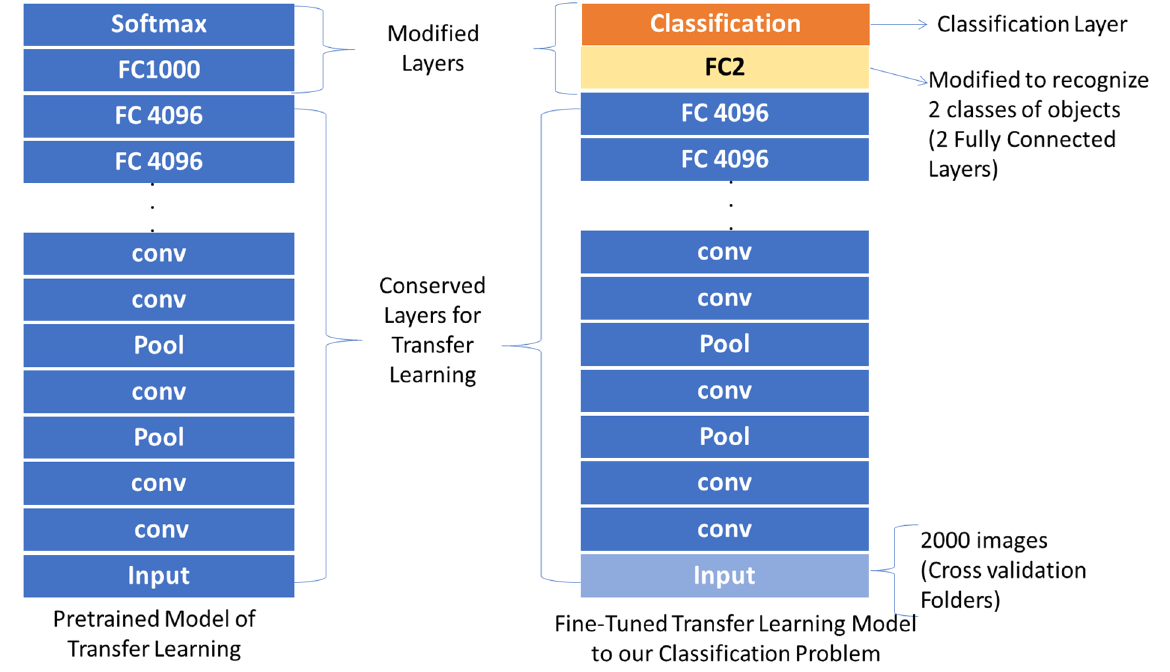
Figure 6. Modifying Transfer Learning Models for This Proposal.